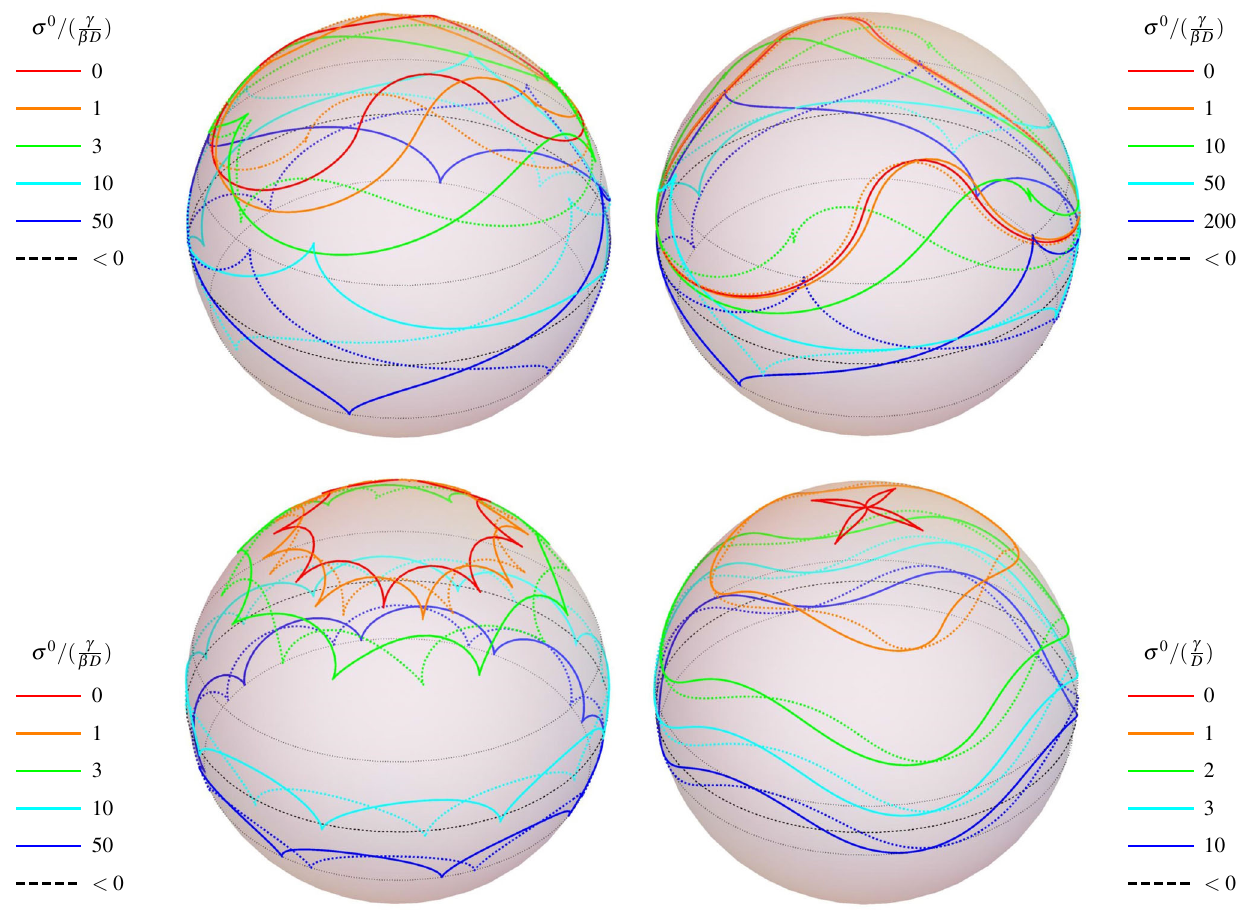
Fig. 24 The dressed elliptic string solutions that reveal instabilities of their seed elliptic strings. The dashed lines correspond to times oppo- site to the continuous ones with the same color. On the top row, the two solutions related to an elliptic string, with a translationally invariant oscillatory counterpart with E = 9 μ 2 / 10 and n = 4, are depicted. The